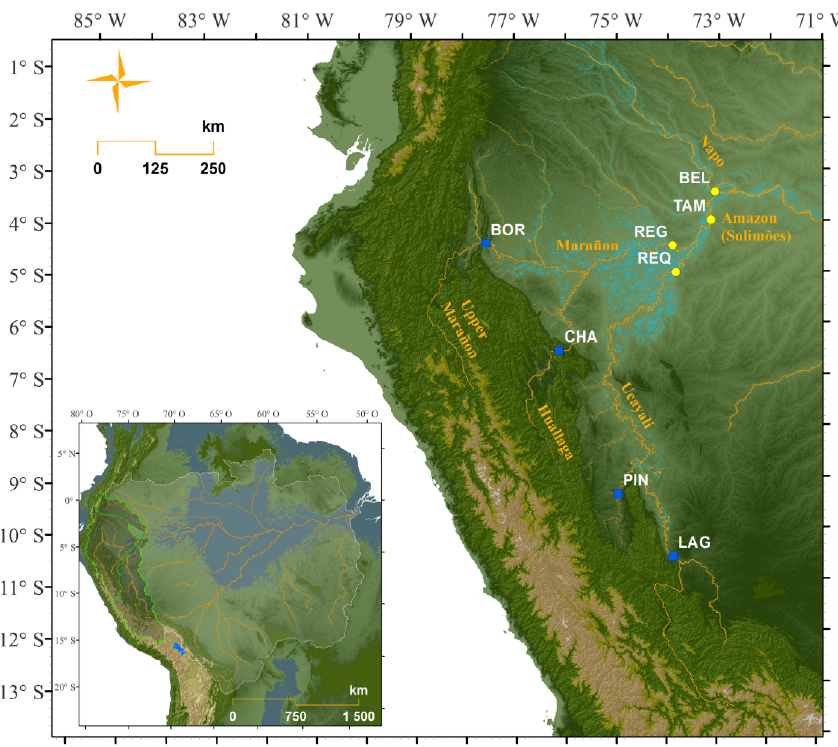
Figure 1. Location of the sampling sites in the Amazon Basin. Blue squares represent piedmont gauging stations, yellow dots represent lowland gauging stations and cyan represents flooded areas. Table 1. Hydrologic and sample dataset for the eight sampling